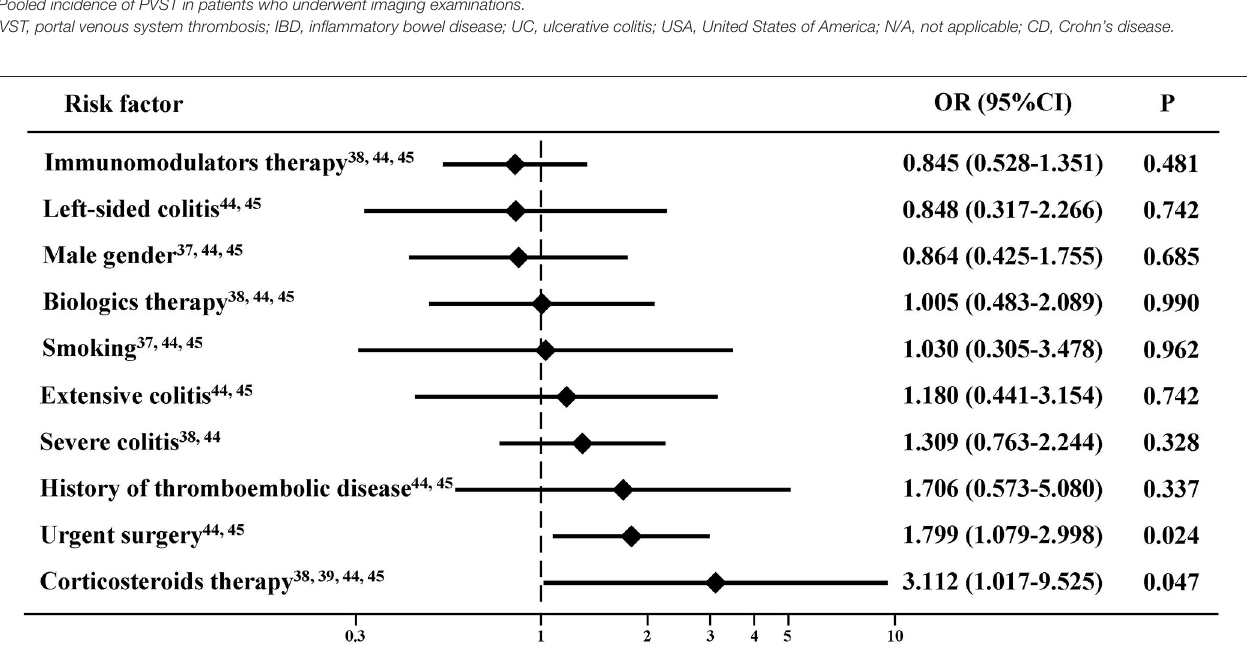
of PVST (7). Second, the deficiency of anticoagulants, such as protein S, is related to IBD (58). Protein S